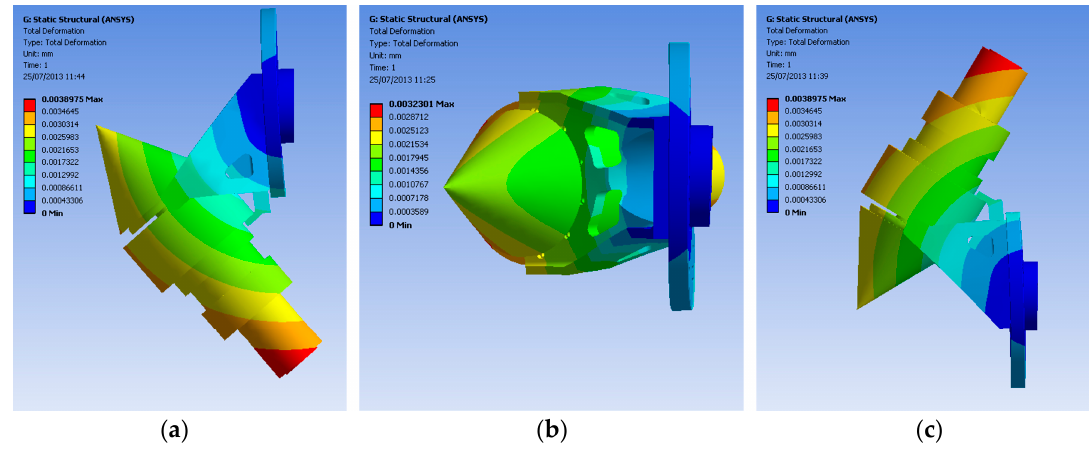
Figure 4. Deformation map for the goniometer from the FEA calculations: ( a ) for ω = 0°; ( b ) for ω = 90°; and ( c ) for ω = 180°. The scale is shown as the degree of deflection in mm.